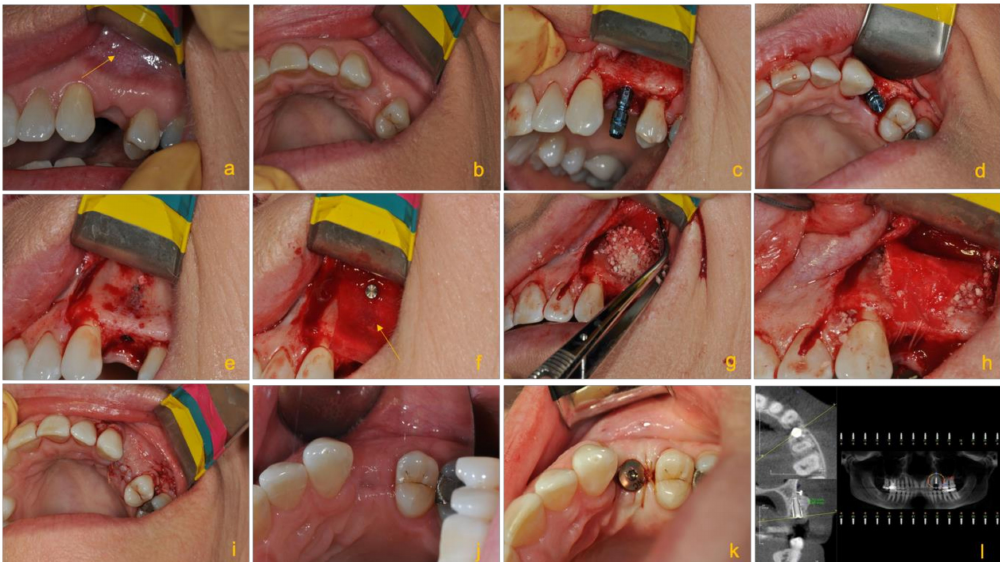
Figure 3. Clinical images illustrating the pre- and post-operative (post-op) procedures of an edentulous patient treated with an implant with guided bone tissue regeneration. Images from left to right show: ( a ) the edentulous site after the tooth was extracted; bone defect in the form of buccal concavity is visible in the apical aspect of 24 (yellow arrow). ( b ) Occlusal shot of the edentulous site showing the buccal concavity. ( c ) The correct positioning of the implant (Straumann Bone Level Tapered 3.3 × 10 mm implant). ( d ) Proper bucco-palatal positioning of the implant. (e) Decorticated area to prior to placement of the bone and complete absence of the buccal bone at the apical part of the implant. ( f ) The placement of Straumann Flex Membrane fixed and stabilized by tacks (AutoTac by BioHorizons Canada). ( g ) Applying bone graft particles comprising of a mixture of Allograft and Xenograft (both from Straumann ® ) packed at the buccal bone defect. ( h ) Periosteal sutures used to stabilize and fix the bone graft inside the membrane, which ensures immobilization of graft resulting in optimal bone regeneration vs. fibrous tissue formation. ( i ) Primary closure of the site. ( j ) Showing post-op. Primary closure is intact. ( k ) The implant after second stage and osseointegration check. ( l ) Five months later, post-op cone beam computed tomography (CBCT) illustrating the final bone healing prior to second stage and osseointegration check of the implant. The post-op CBCT revealing a gain of over 5 mm of bone (courtesy of Dr. Mohammad A. Javaid, Periodontist, British Columbia,